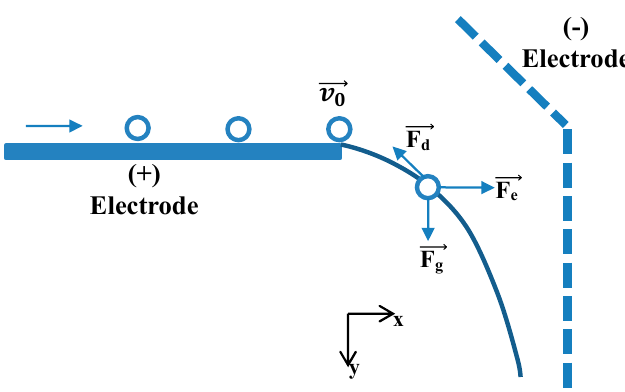
Figure 1. Forces acting on particles in electrostatic separation.